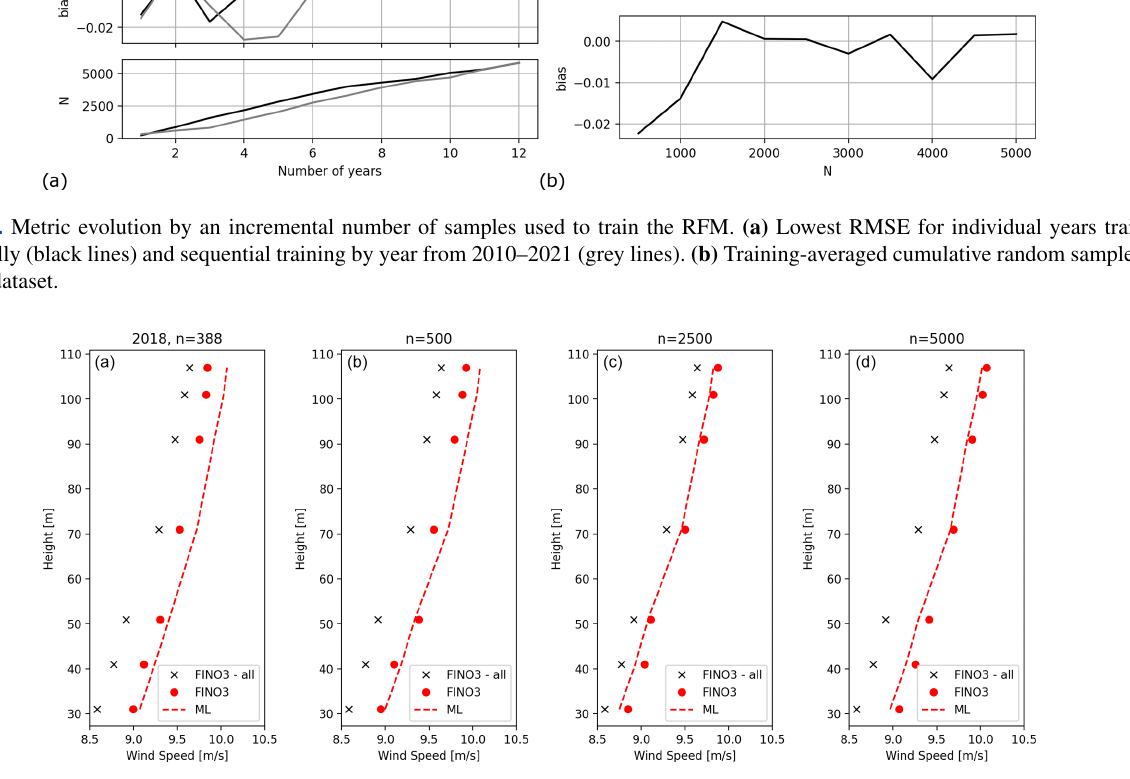
Figure 9. (a) RFM mean wind profile for 2018 using the full dataset. (b–d) RFM wind profile trained on a subset of 500, 2500 and 5000 random samples from the total dataset. Red dots represent FINO3 average wind measurements of the training dataset; black x symbols represent the mean FINO3 values for